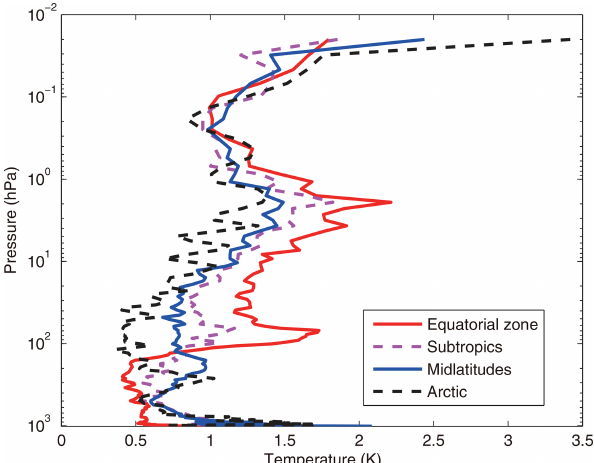
Figure 12. The temperature standard deviation of ICS in four typ- ical regions. The red line indicates the result from the equatorial zone. The dashed pink line represents the result from the subtropics. The blue line represents the result from midlatitudes. The dashed black line stands for the result from the